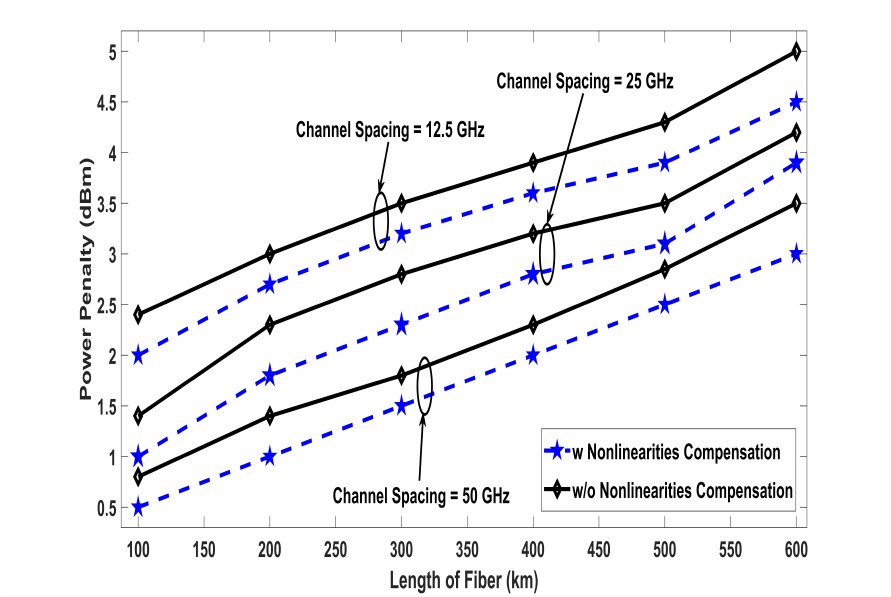
Figure 6. Normalized signal to noise ratio against BER for 0, 2.5, 5 and 8 deg PEs at 10 km of path cover and 60 GHz of RF.